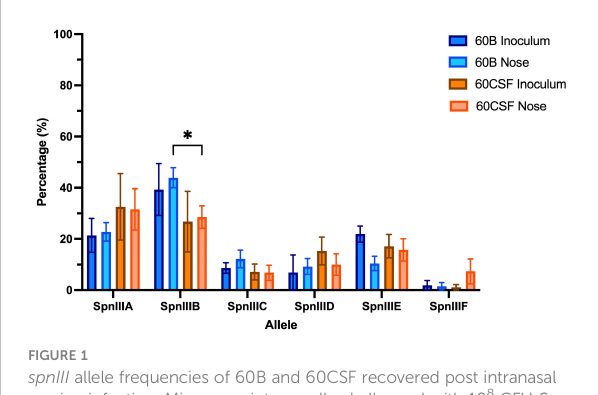
FIGURE 1 spnIII allele frequencies of 60B and 60CSF recovered post intranasal murine infection. Mice were intranasally challenged with 10 8 CFU S. pneumoniae serotype 15C ST8711 blood isolate (60B) or CSF isolate (60CSF). At 24 h, mice from each group were humanely euthanized and pneumococci in the nasal tissue were harvested. spnIII allele quanti fi cation was performed on DNA extracted from the original inoculum and colonies grown from nasopharynx samples. Allele percentages for original inoculum and bacteria recovered from noses are represented. Statistical analysis was performed using two-way analysis of variance and a Tukey post-comparison test; *P < 0.05.